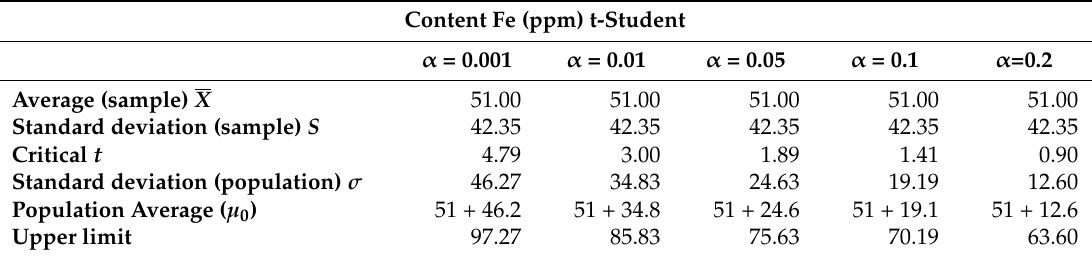
Table 3. Application of t-student test to iron content—Fe (ppm).